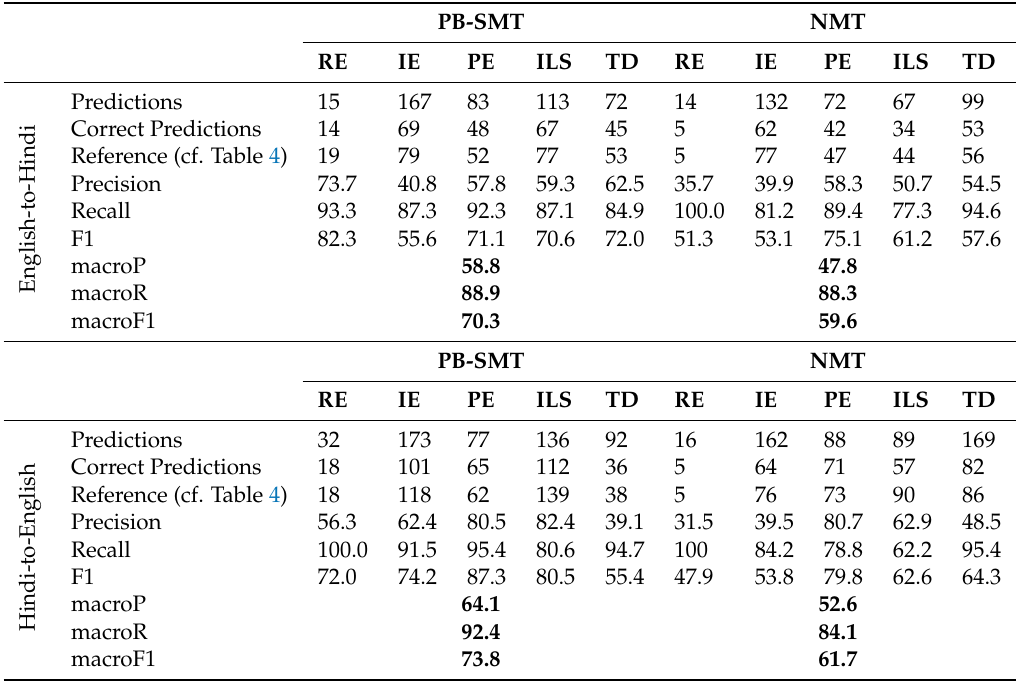
Table 12. Performance of TermCat in precision, recall and F1